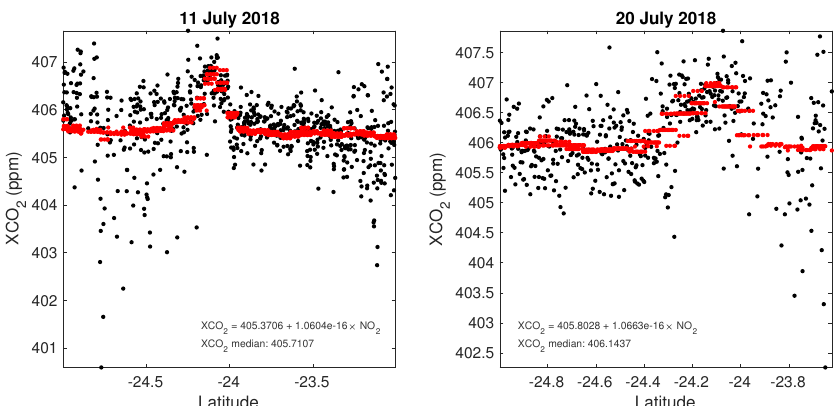
Figure 12. OCO-2 XCO 2 values (black dots) as a function of latitude on 11 July 2018 and 20 July 2018. The enhancement corresponds to plumes originating from Medupi and Matimba coal-fired power plants. The red dots indicate the XCO 2 values obtained by converting TROPOMI NO 2 tropospheric columns (collocated to the OCO-2 measurements) into XCO 2 using the results of the linear regression between the two data sets. The slope (CO 2 -to-NO 2 ratio) is in both cases ~1.1 × 10 − 16 ppm/(molec./cm 2